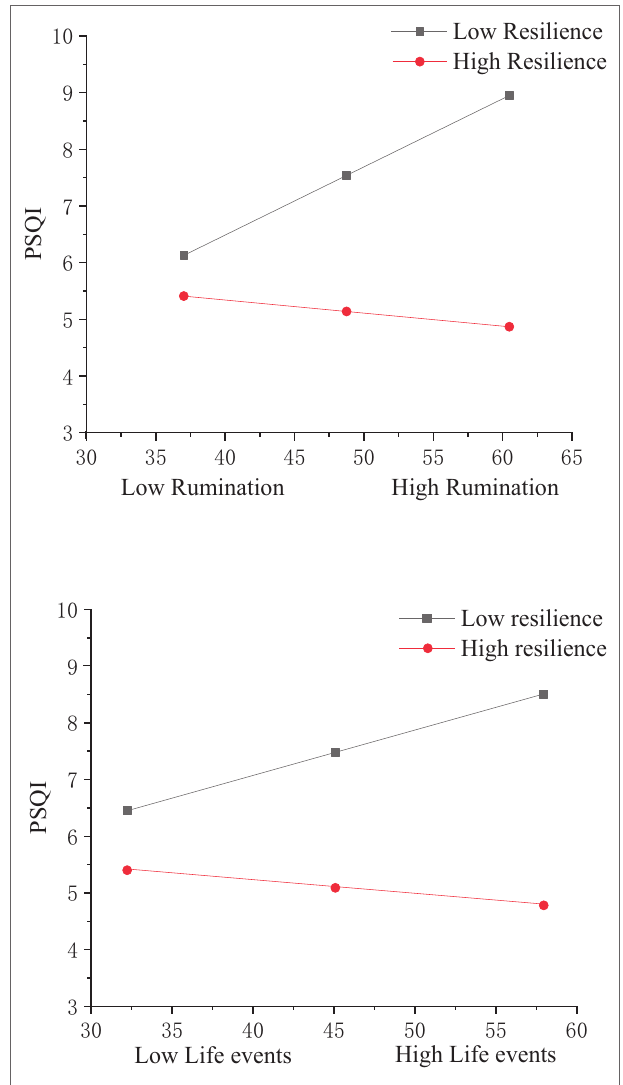
FIGURE 2 | Simple slope analyses of the moderating effect of psychological